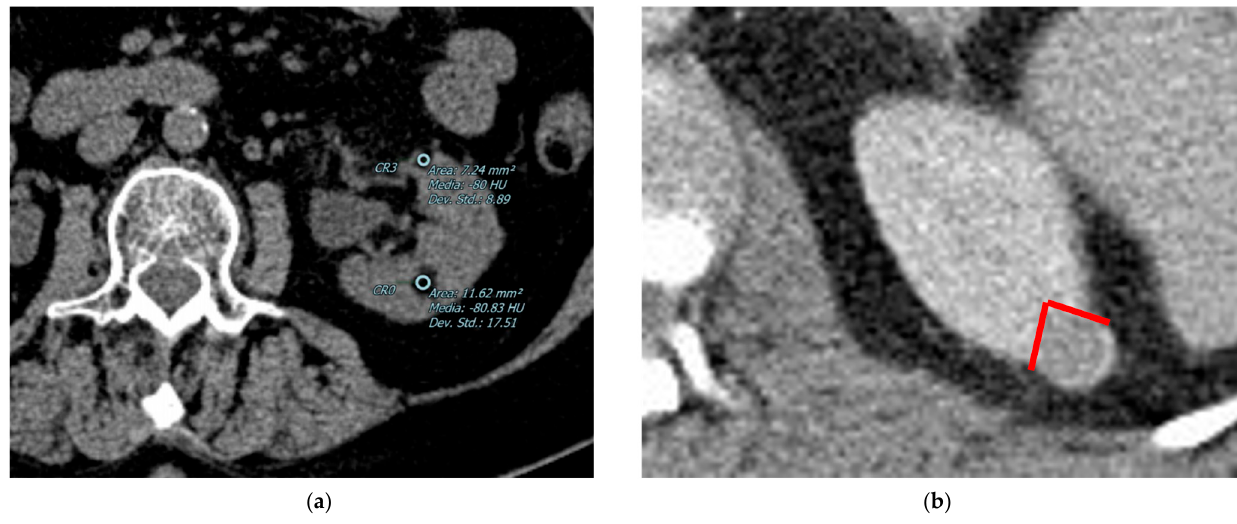
Figure 1. Abdominal CECT of a 77-year-old female patient: ( a ) the left kidney contains two cortical formations, the first in the middle-upper third (12 mm) and the second in the middle-lower third (11 mm), both with a preponderant macroscopic fat component. Both lesions show an average density lower than 20 units ( − 80 and − 80 HU, respectively) and hence consistent with angiomyolipomas. ( b ) An example of a typical lipid-poor AML: the lesion is exophytic with a peculiar angular interface (red lines). Both these features help the radiologist in the